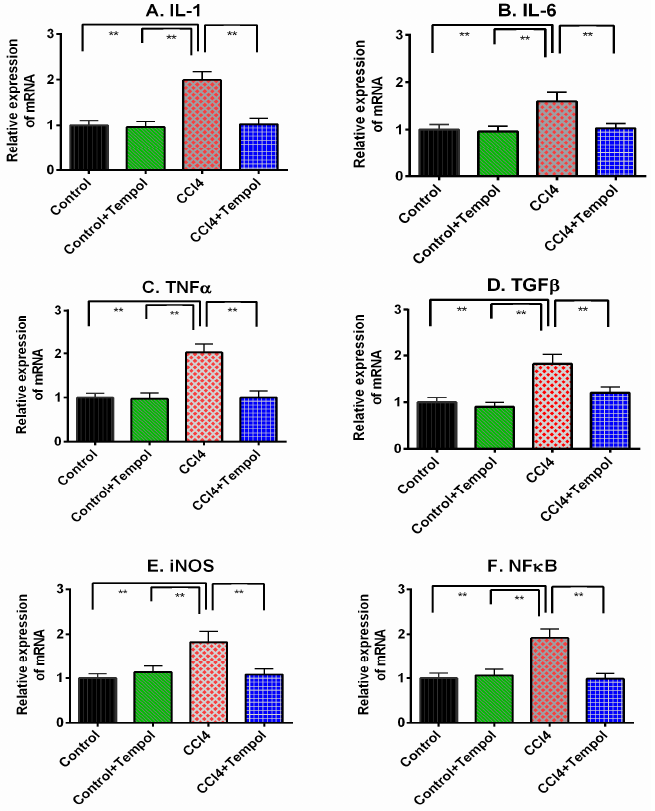
Figure 7. Effect of tempol on inflammation related gene expression in liver of CCl 4 -administered rats. Every value was represented as mean ± SEM. N = 6. One-way ANOVA followed by Tukey test were performed for statistical analysis. For statistical significance, p ≤ 0.05 is considered as significance in all cases. Here, ** means p ≤ 0.001.